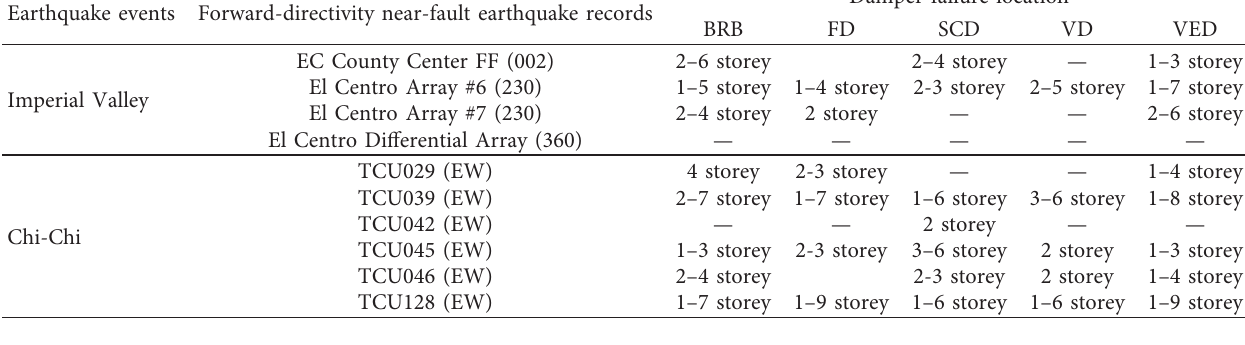
Table 7: Damper failure conditions under the RE of forward-directivity near-fault earthquakes. Earthquake events Forward-directivity near-fault earthquake